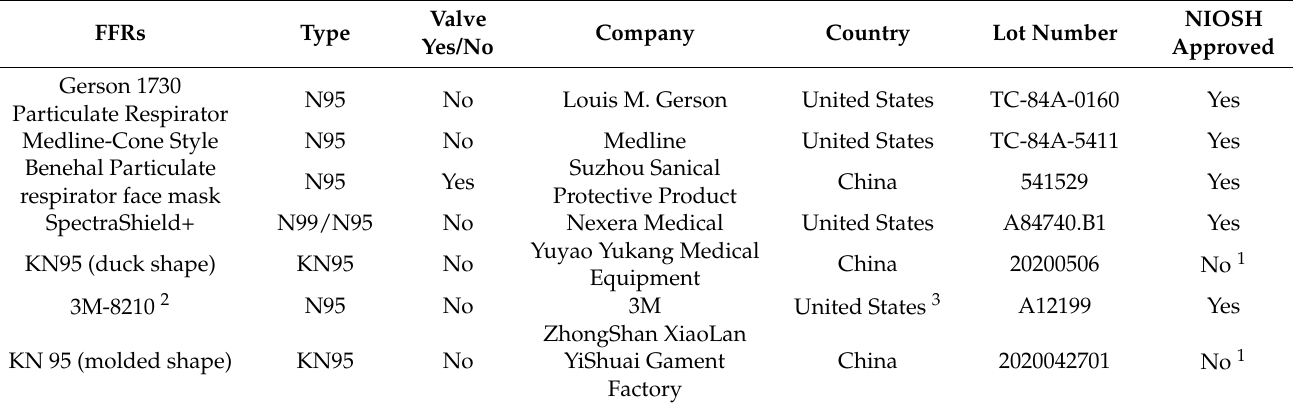
Table 1. Description of FFRs used in the